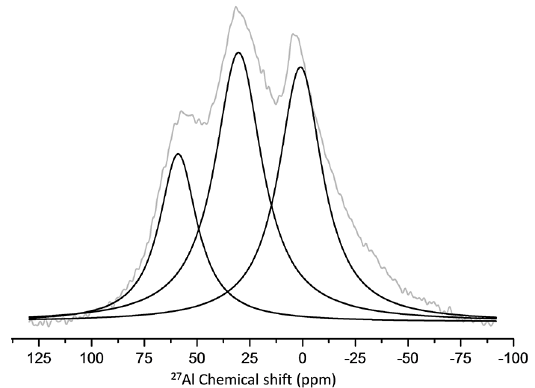
Figure 6. 27 Al NMR spectrum deconvolution of the synthetic aluminosilicate heat treated at 900 °C, with coefficient of determination (r 2 ) = 0.992.